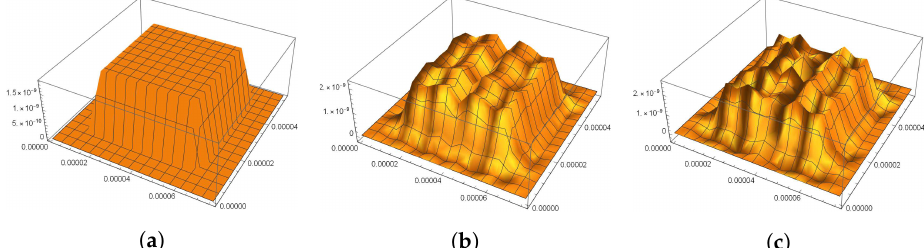
Figure 9. Recovery of a discontinuous load. ( a ) Target load. ( b ) Attainable target load. ( c ) Recovered load (error level (cid:101) e =